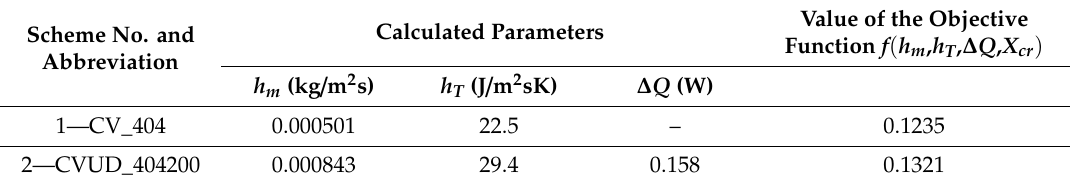
Table 3. Results of the model parameter determination for apple Table 2. Results of the model parameters determination for carrot samples.